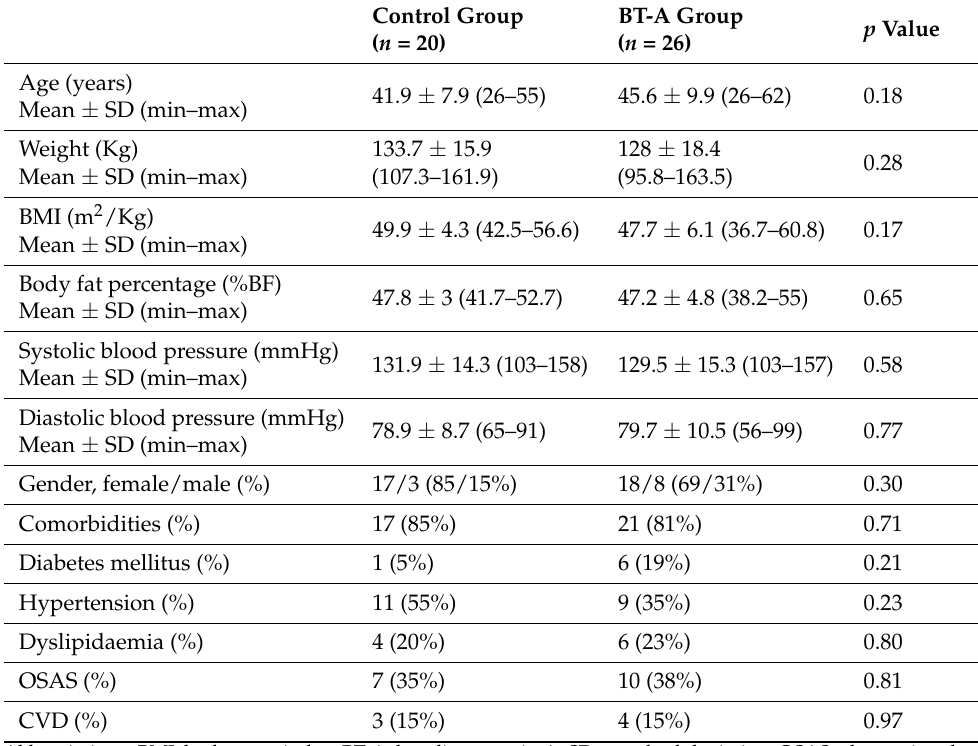
Table 1. Baseline characteristics: comparison between groups.